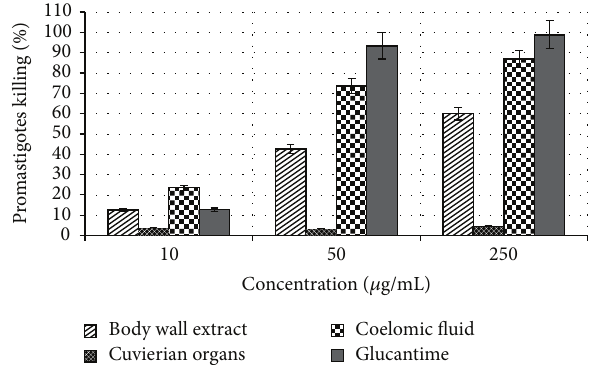
Figure 1: Time dependent leishmanicidal activity of H. leucospilota extracts against L. infantum promastigotes. The results are shown as a percentage of parasite killing from three independent experiments performedastriplicate(mean ± SE)usingMTTassayaftertreatment with 50 𝜇 g/mL of each sample tested.